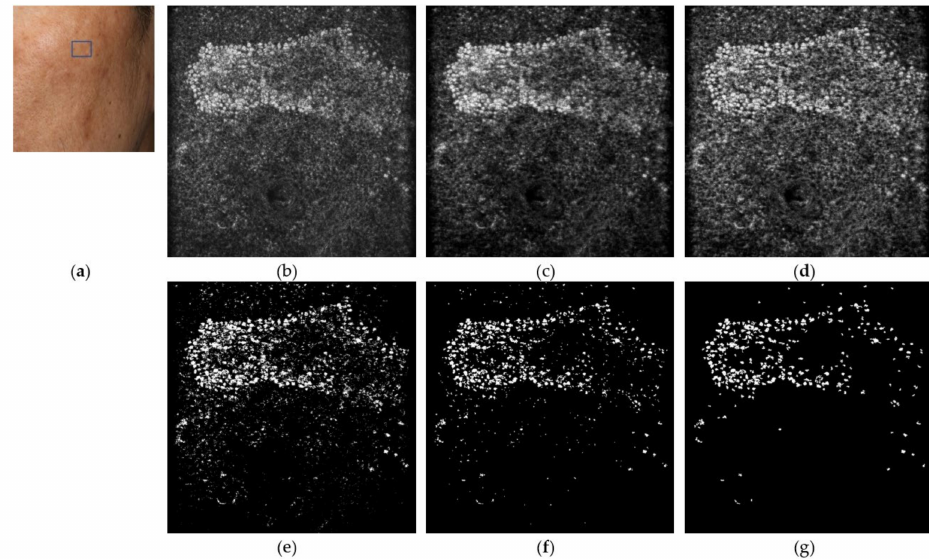
Figure 5. Illustration of automatic melanin segmentation in CADe system. ( a ) Clinical image of the imaged melasma lesions (rectangular) on the cheek. ( b ) The original en face scan (E-scan) image. ( c ) The image after SC-DnCNN. ( d ) The image after performing contrast-limited adaptive histogram equalization (CLAHE). ( e ) The candidate targets segmented by thresholding. ( f ) The selected grain melanin after image opening. ( g ) The selected confetti melanin after morphological operations. The field of view is 475 × 476 µ